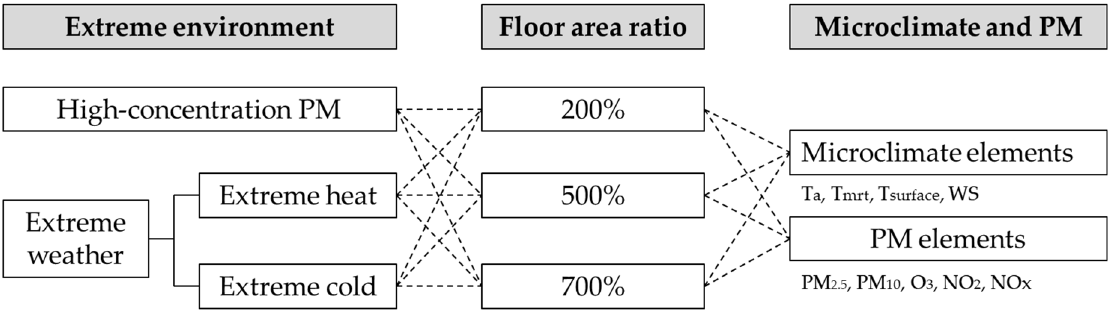
Figure 1. Outline of the case study.